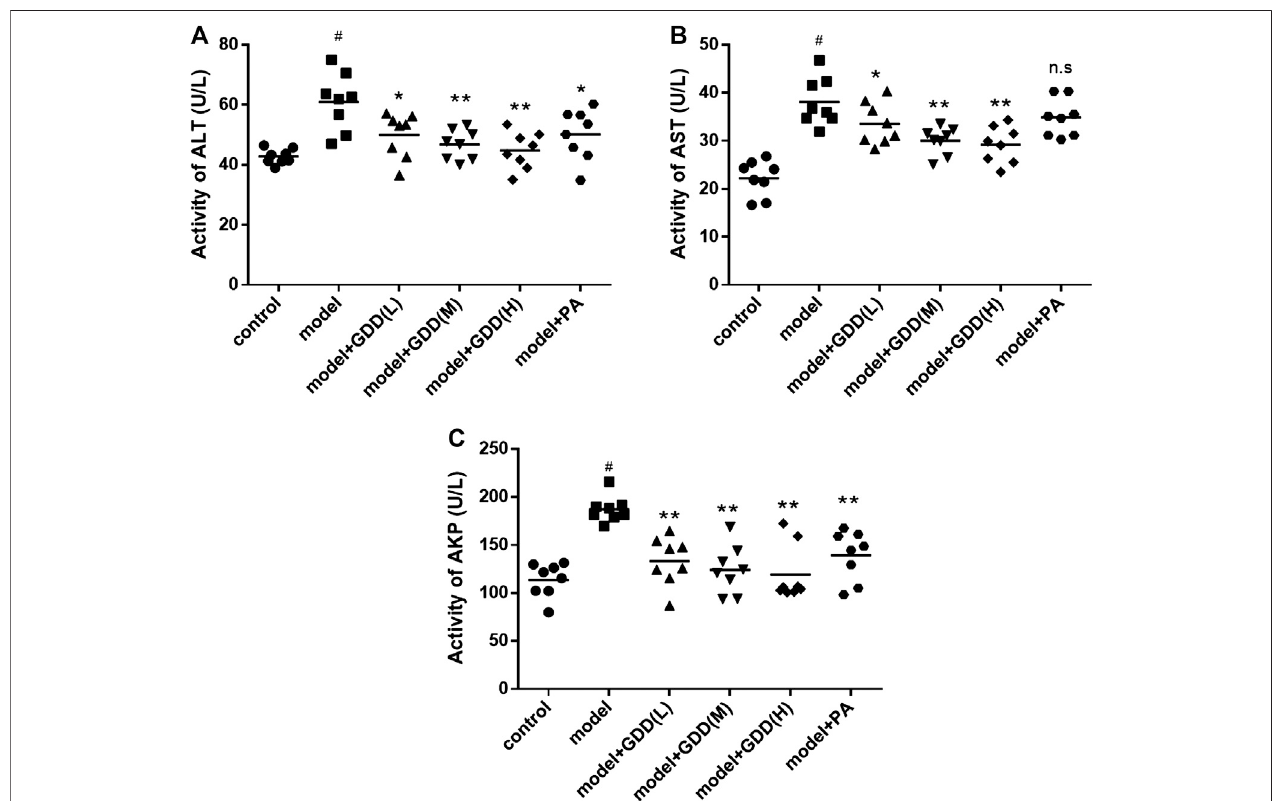
FIGURE 7 | Effects of GDD on activity of ALT (A) , AST (B) , AKP (C) in the serum. # p < 0.01, compared with the control group; * p < 0.05, compared with model group; ** p < 0.01, compared with model group; n.s, not signi fi cant.